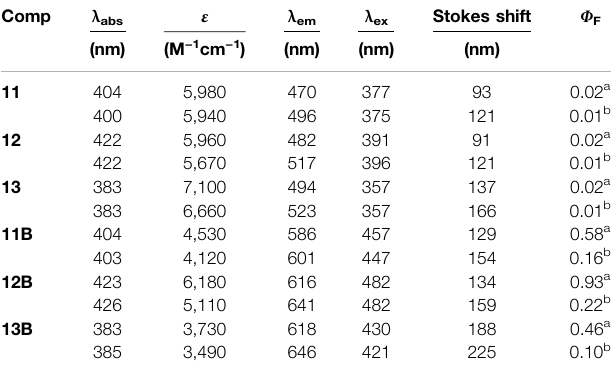
TABLE 2 | Optical properties of compounds 11 – 13 , 11B – 13B